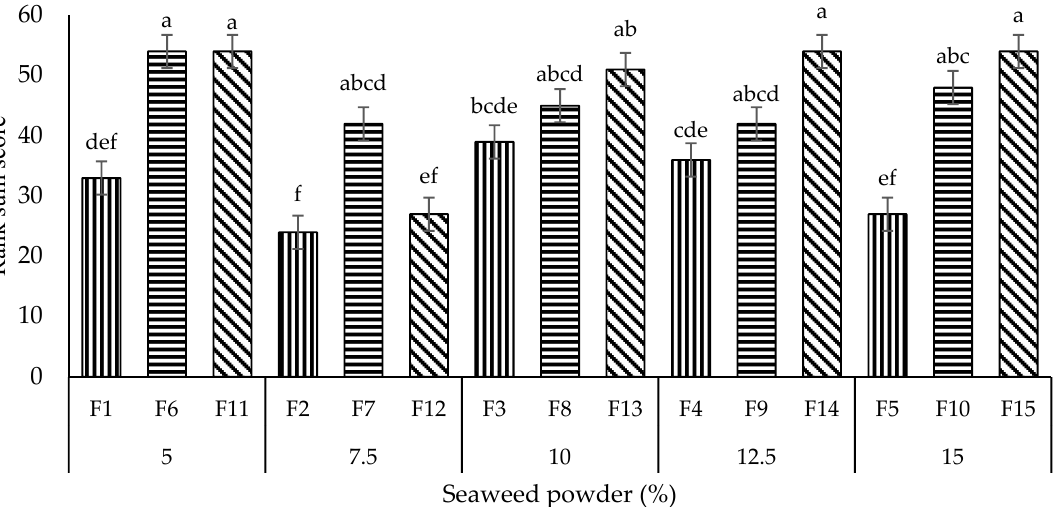
Figure 7. Rank sum scores for all the noodles samples. Lower rank-sum scores indicate a higher overall preference, whereas higher rank-sum scores indicate a lower preference. a-f with different superscripts show the significant difference among the noodles samples (Friedman test, LSD, p < 0.05). Bars with vertical, horizontal, and diagonal patterns = wheat flour: potato starch ratios of 9:1, 8:2, and 7:3, respectively.